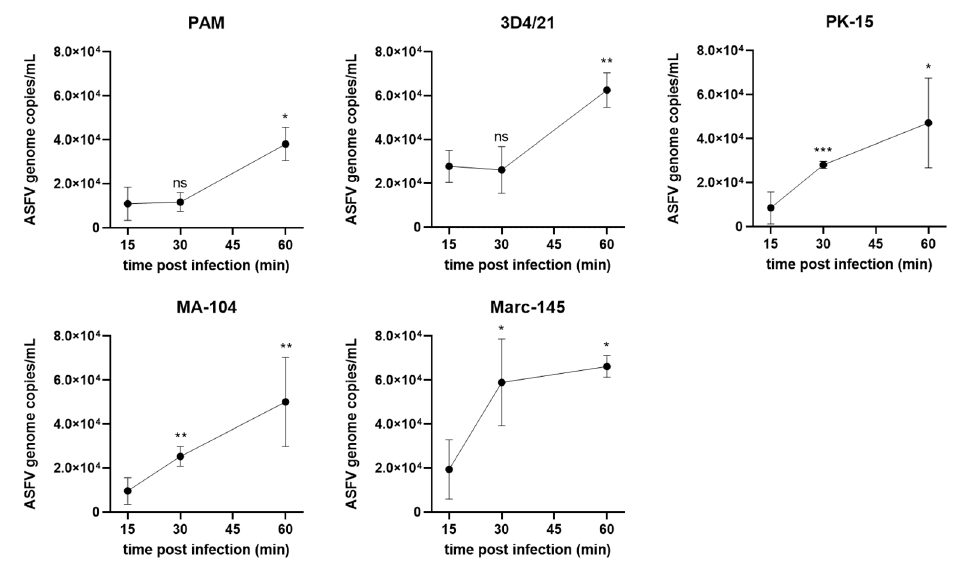
Figure 2. ASFV genomic DNA quantification after attachment on PAMs, 3D4/21, PK-15, MA-104 and Marc-145 cells. The cells were infected with ASFV at 5 MOI and incubated at 4 ◦ C for 15 min, 30 min and 1 h for detection of virus attachment. ASFV genomic DNA was quantified with real-time PCR with primers targeting B646L gene. Results are presented as the mean ± SD of data from three independent experiments; ns, not significant; *, p < 0.05; **, p < 0.01, ***, p < 0.005.